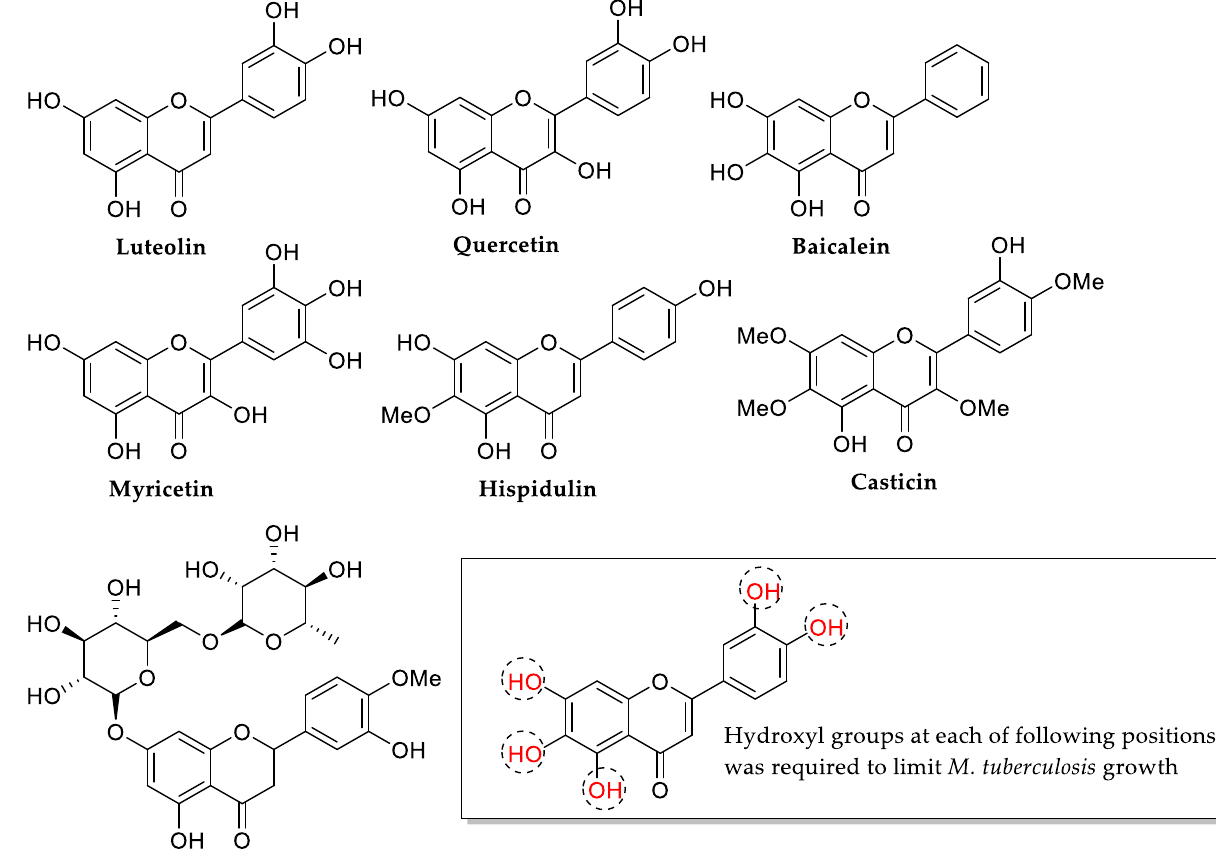
Figure 7. Chemical structures of several tested flavonoids and their specific structural requirements for antitubercular activity ( Mycobacterium tuberculosis ) [74].